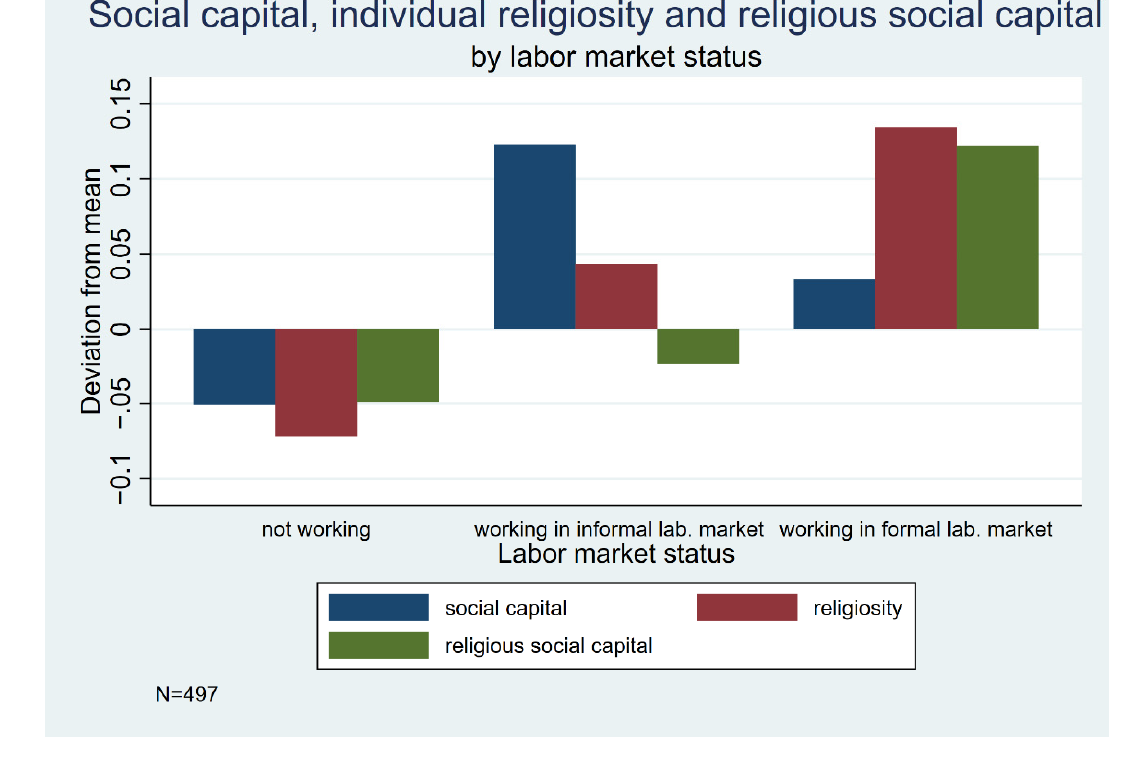
Figure 4. Social capital, individual religiosity, and religious social capital by labor market status. Table 7. Estimation